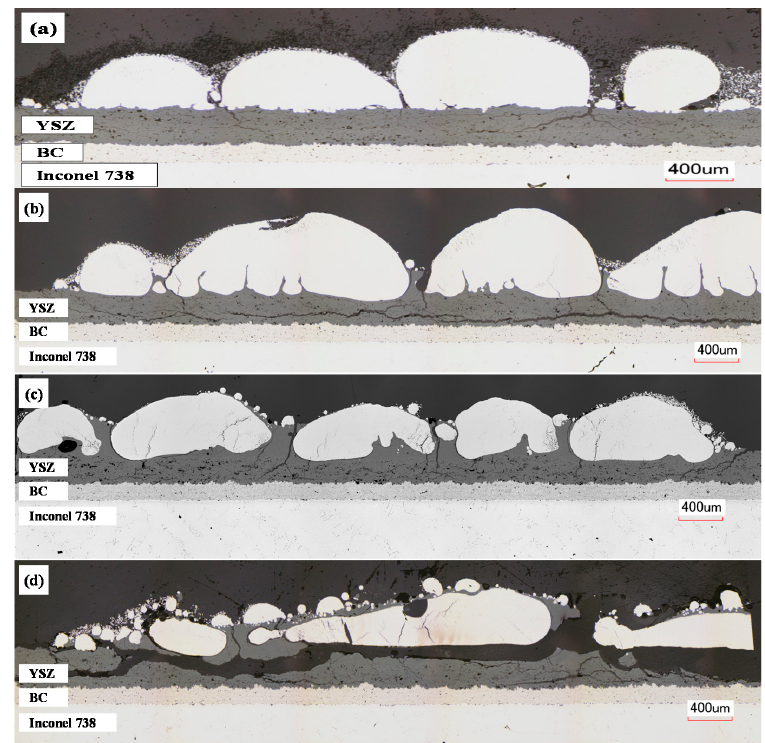
Figure 4. Cross sections of tracks produced with different process parameters from alumel feedstock under a laser microscope. v S = 400 mm/min, d S = 0.984 mm, f F = 1.7 g/min, f C = f P = 10 L/min. ( a ) P L = 50 W;